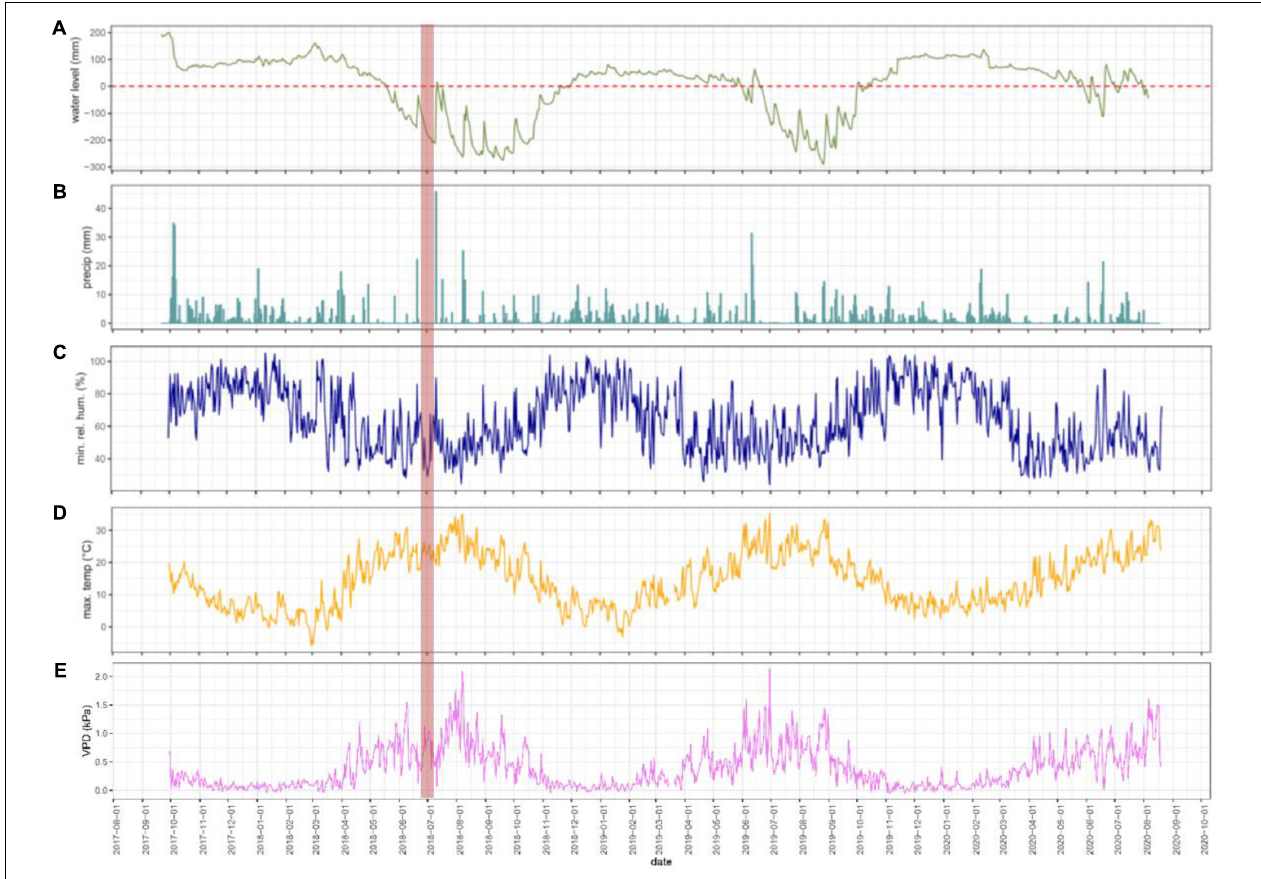
FIGURE 5 | Daily time series of (A) water level (B) precipitation (C) minimum relative humidity (D) maximum air temperature (E) mean vapor pressure deficit at PW. Dashed lines in panel (A) represents the peat surface while positive values indicate aboveground and negative values indicate belowground. An example of rapid water level decline during high maximum daily air temperatures and absence of substantial rainfall is indicated by the translucent pink